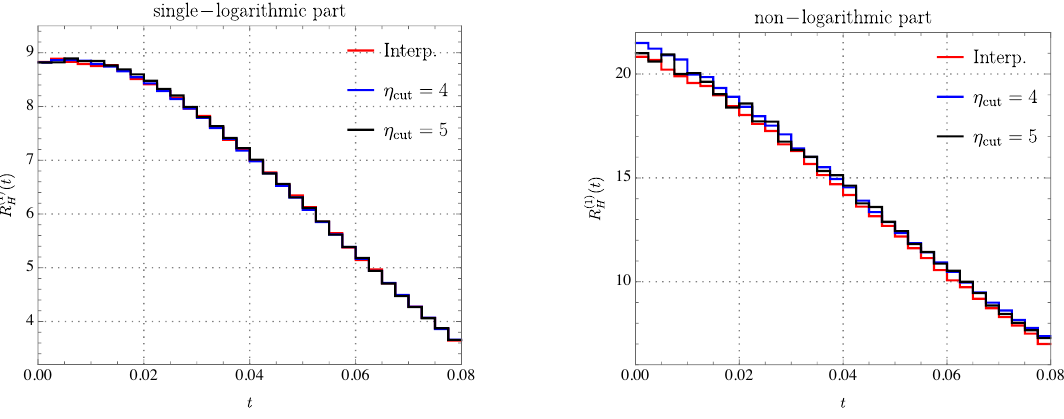
Figure 12 . Numerical comparison among di(cid:11)erent Monte Carlo implementations of the one-loop hard corrections R (1) to the gap fraction. The red line corresponds to the interpolation method, H the other two are obtained using the slicing method with di(cid:11)erent values of the cuto(cid:11) (cid:17) cut . Left: coe(cid:14)cient of the single logarithmic part. Right: non-logarithmic